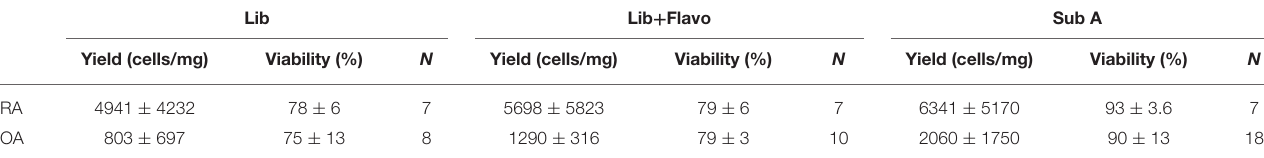
Disaggregation of RA tissue yielded more cells than OA tissue but was not significantly different among techniques. Sub A improved viability of disaggregated cells compared to Lib (OA p = 0.013; RA p = 0.023).